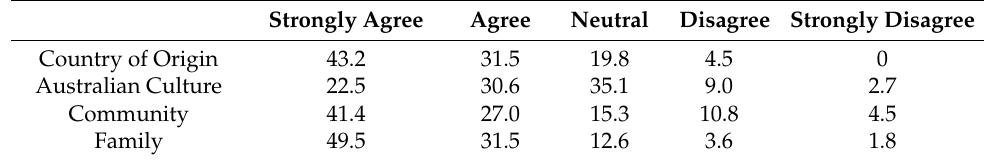
Table 2. Cultural identity in relation to participants’ perceived cultural connectedness (%).